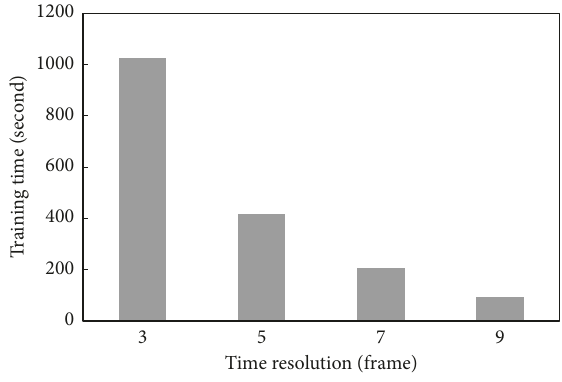
Figure 18: Training and validation results. Table 3: Prediction results of SF values.